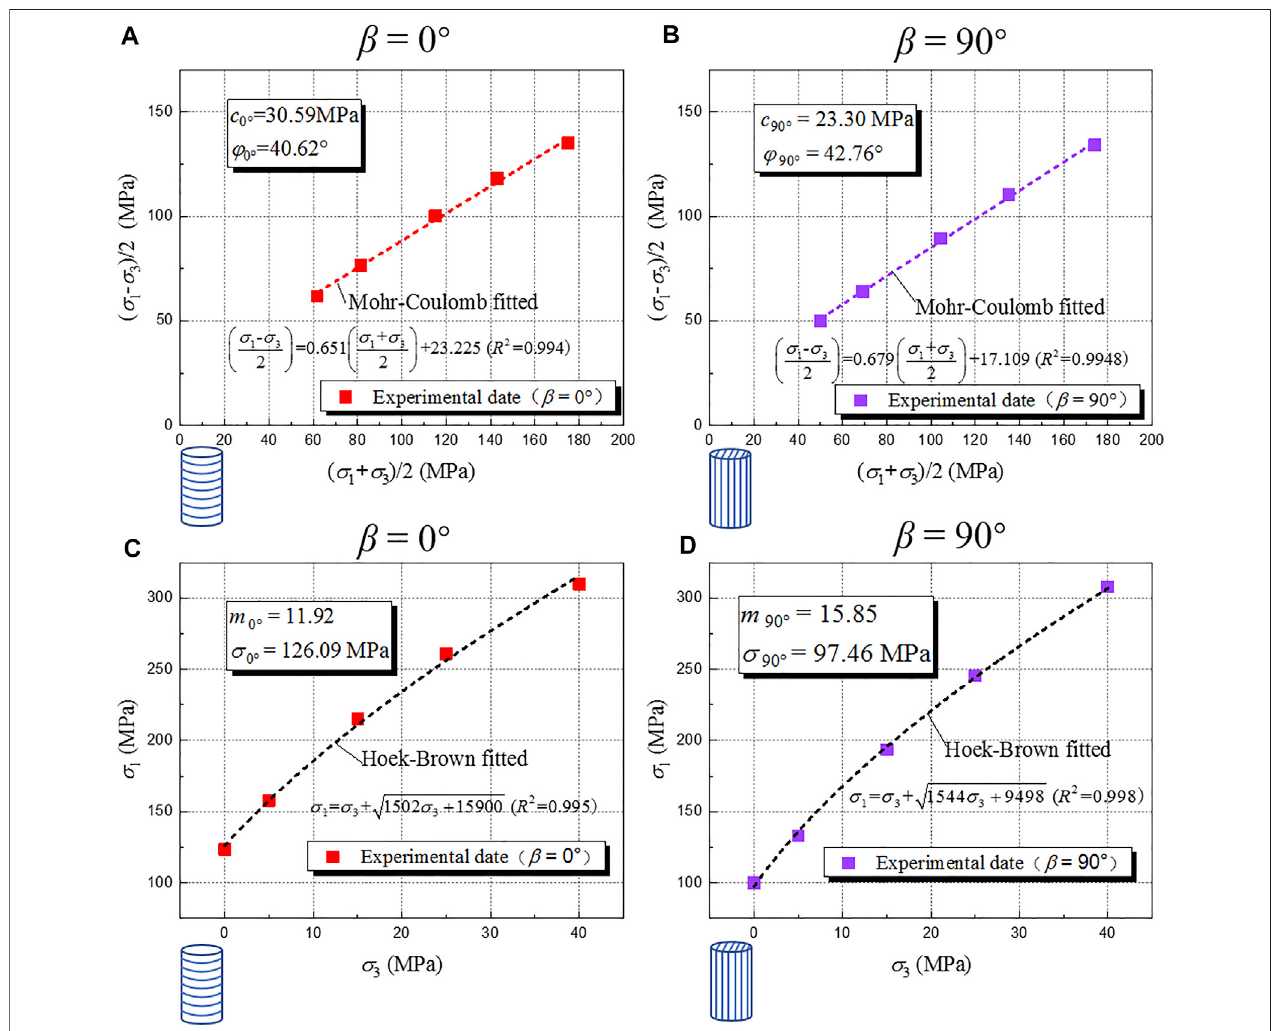
FIGURE 10 | Determination of strength parameters of layered sandstone. (A) Mohr – Coulomb strength of bedded sandstone with horizontal bedding dip, (B) Mohr – Coulomb strength of bedded sandstone with vertical bedding dip, (C) Hoek – Brown strength of bedded sandstone with horizontal bedding dip, and (D) Hoek – Brown strength of bedded sandstone with vertical bedding